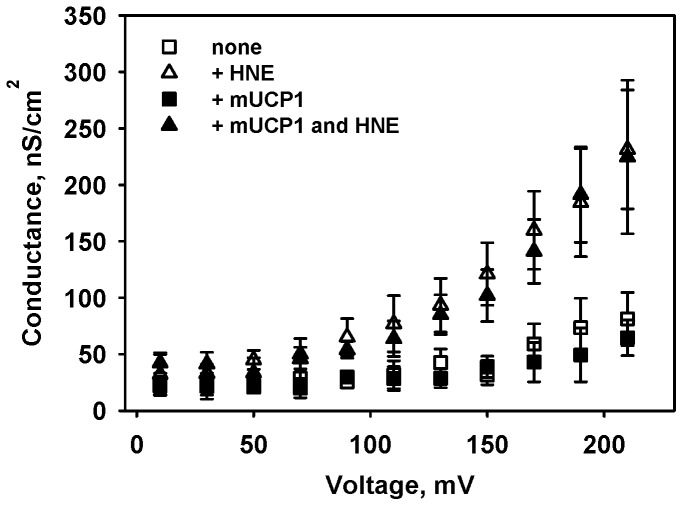
Effect of membrane potential on the HNE-mediated membrane conductance in the absence of AA.The concentration of membrane E. coli polar lipid, UCP1 and HNE were 1/ml, 5.5 µg/mg of lipid, and 0.86 mM. Buffer solution contained 50 mM K2SO4, 25 mM TES, 0.6 mM EGTA at pH 7.4 and T = 32°C. Data points represent mean ± standard deviation from 3–5 independent experiments.